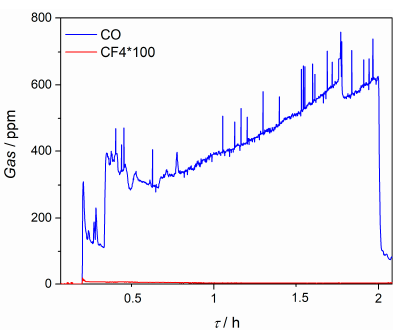
Figure 7 . Gases evolved on the GC anode during potentiostatic Nd deposition at − 0.80 V on Mo electrode from the electrolyte used.